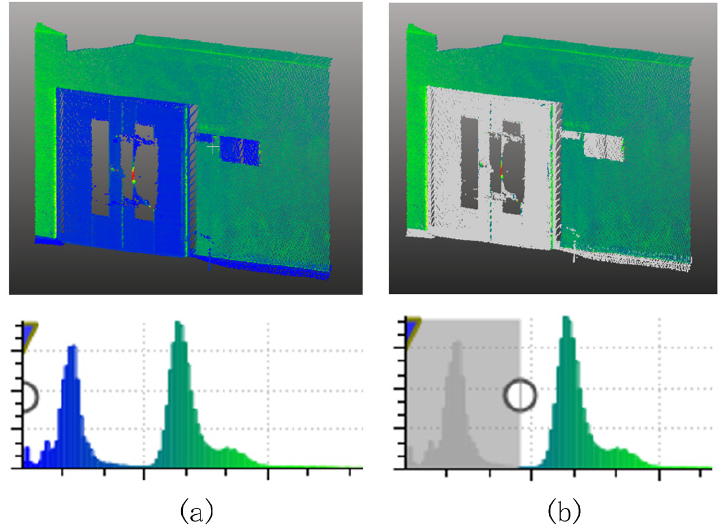
Figure 4. Removal of data points representing coplanar doors: ( a ) the intensity histogram for a region with a coplanar door, ( b ) filtering out the points in the lower peak of the intensity histogram.